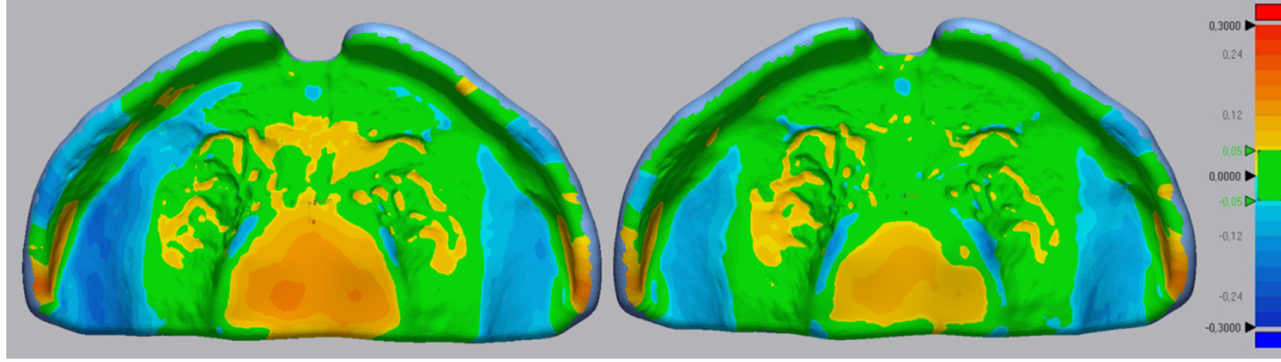
Figure 8. Exemplary files for the trueness color maps for the conventional samples. The color maps display a critical deviation of ± 300 µ m and a nominal deviation of ± 50 µ m (color range in